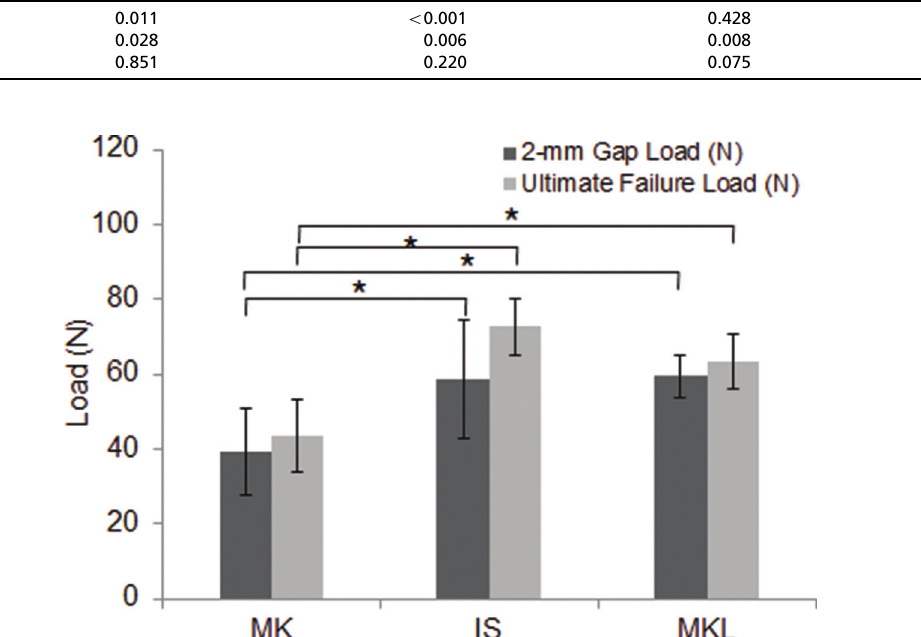
Table 3 - p- values for comparisons between flexor tendon suture techniques. Comparison